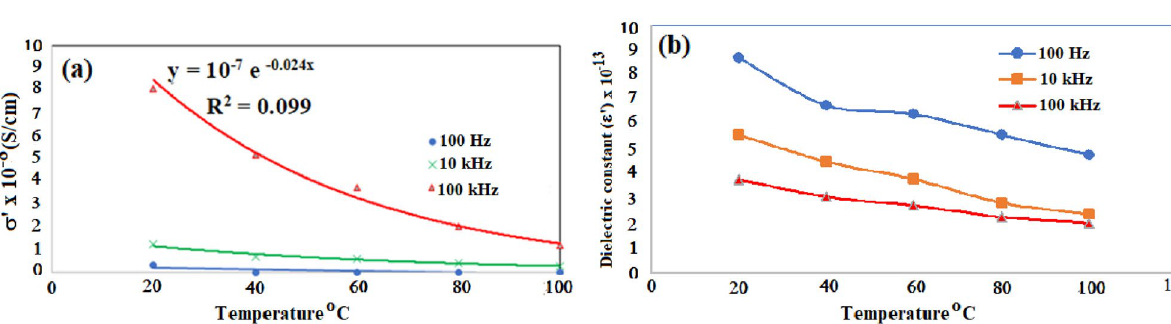
Figure 9. The variation of conductivity σ ′ vs Temperature for polymer 2 at 100 Hz, 10 kHz and 100 kHz. Polymer concentration (ppm) Ca 2+ ppm % Inhibition 10 900.90 24 50 920.92 29 100 960.96 Table 1. Concentration of free Ca 2+ ion in brine solution in the absence and presence of different concentrations of polymer 2 and their percent of inhibition (C b = 1221.22 ppm and C a = 800.8 ppm).